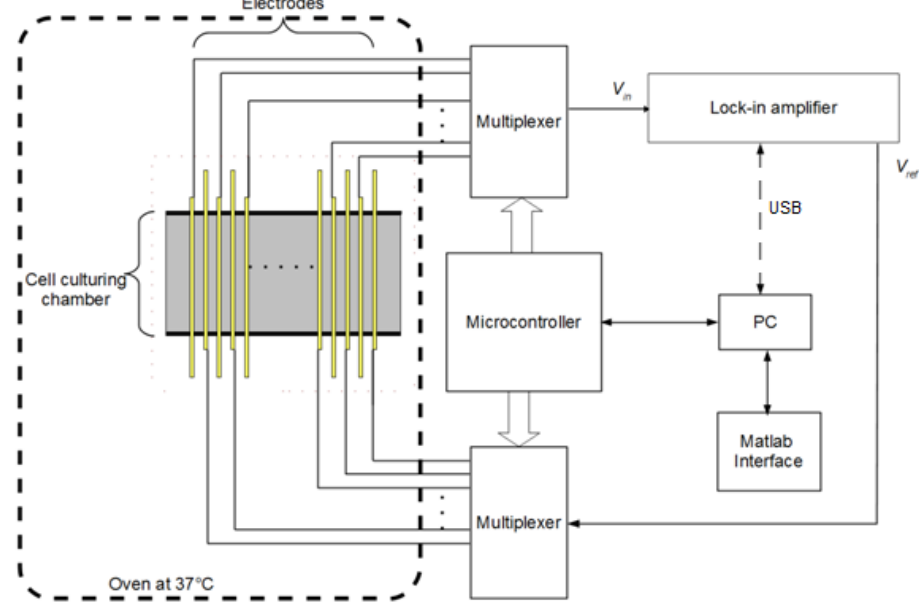
Figure 2. Fabrication process for biosensor electrodes ( Left ) and the PDMS microchamber ( Right ). The two chips are bonded together to form the culturing